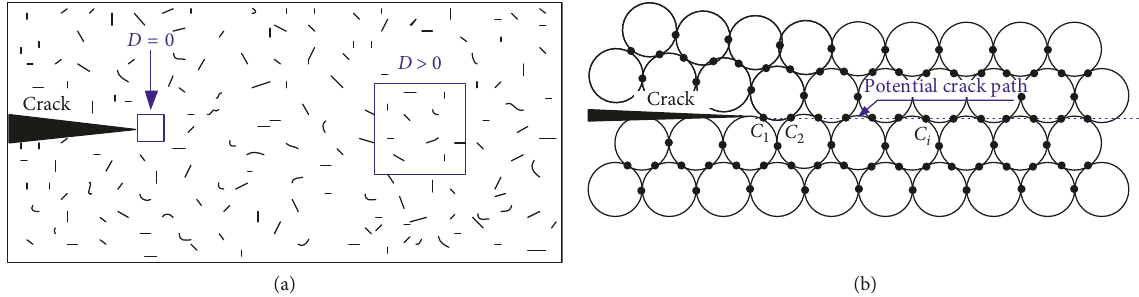
Figure 12: (a) Scale effect on the damage value and (b) contact points in the potential crack